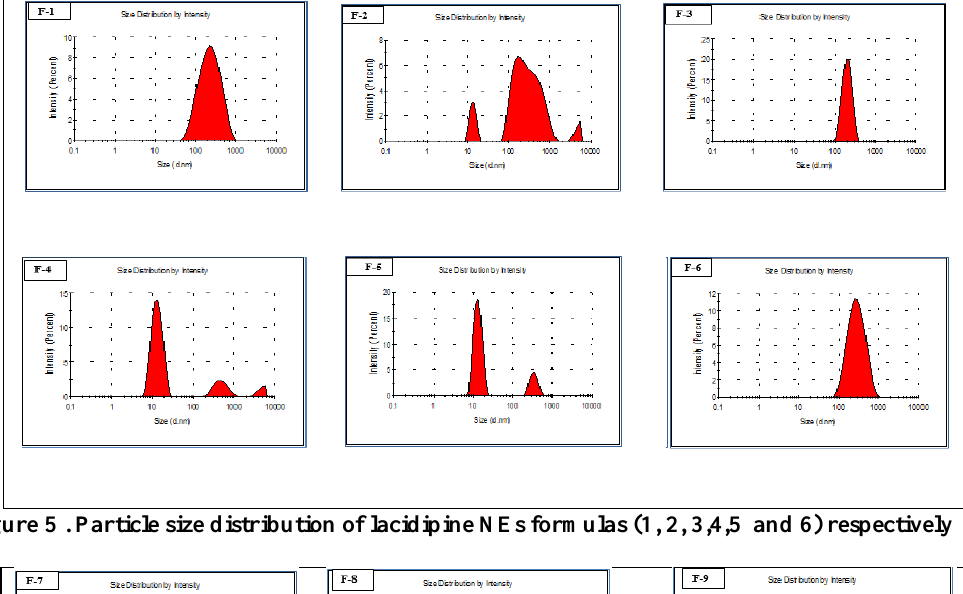
Figure 5 . Particle size distribution of lacidipine NEs formulas (1, 2, 3,4,5 and 6) respectively